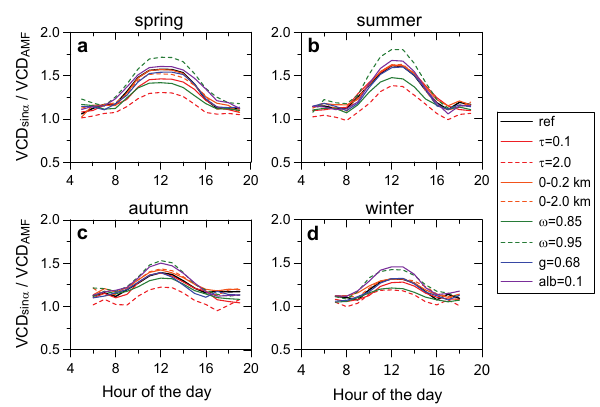
Fig. 4. Ratios of the tropospheric NO 2 VCD, calculated assuming the so-called geometric approximation (VCD sin α ) , to those calcu- lated using various AMFs as simulated by the radiative transfer model (VCD AMF ) , for the 30 ◦ elevation angle in different seasons. Detailed descriptions of parameters used in the AMF calculations are given in Table 1.